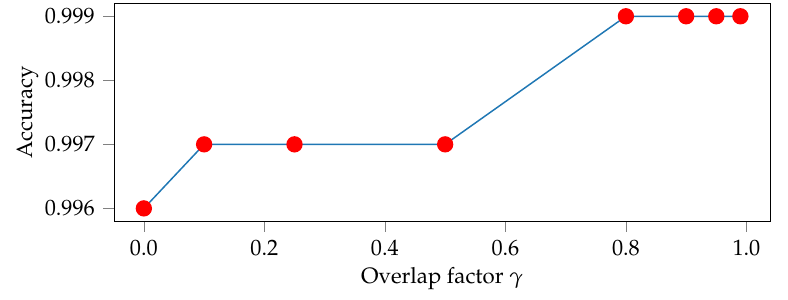
Figure 9. Five-fold cross validation test accuracies for various overlap factors γ .